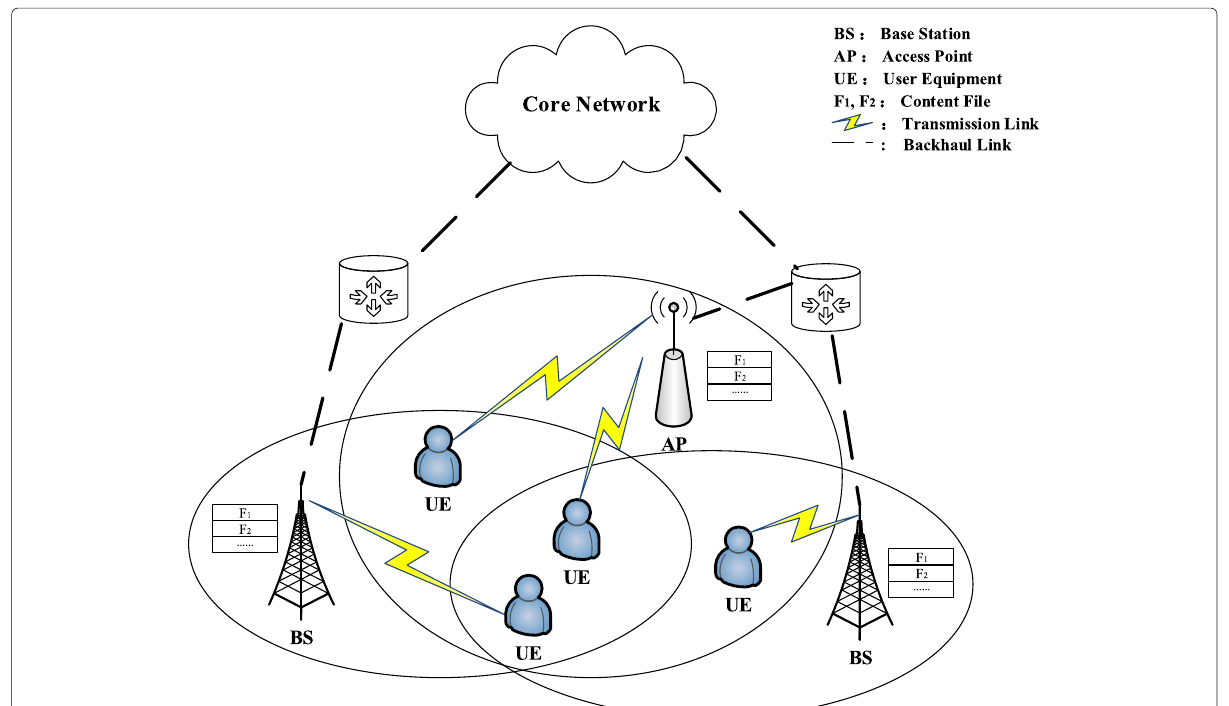
Fig. 1 System model. The system model considered in this